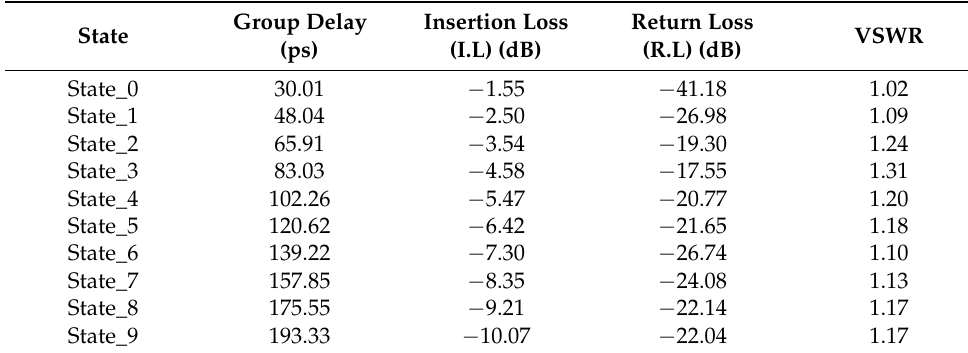
Table 3. Corresponding TTDL network performance of each switch state (@42GHz).